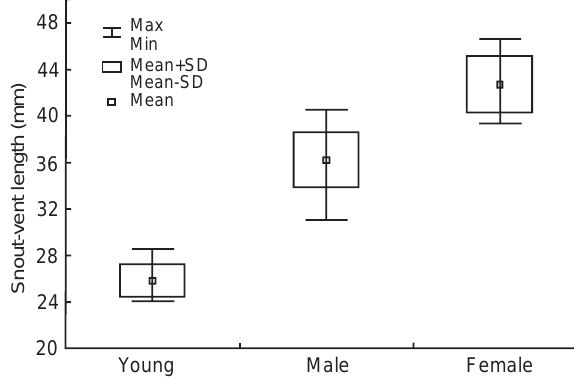
Figure 1. Snout-vent length (SVL) of juvenile and adult male and female specimens of H. luederwaldti recorded in the Parque